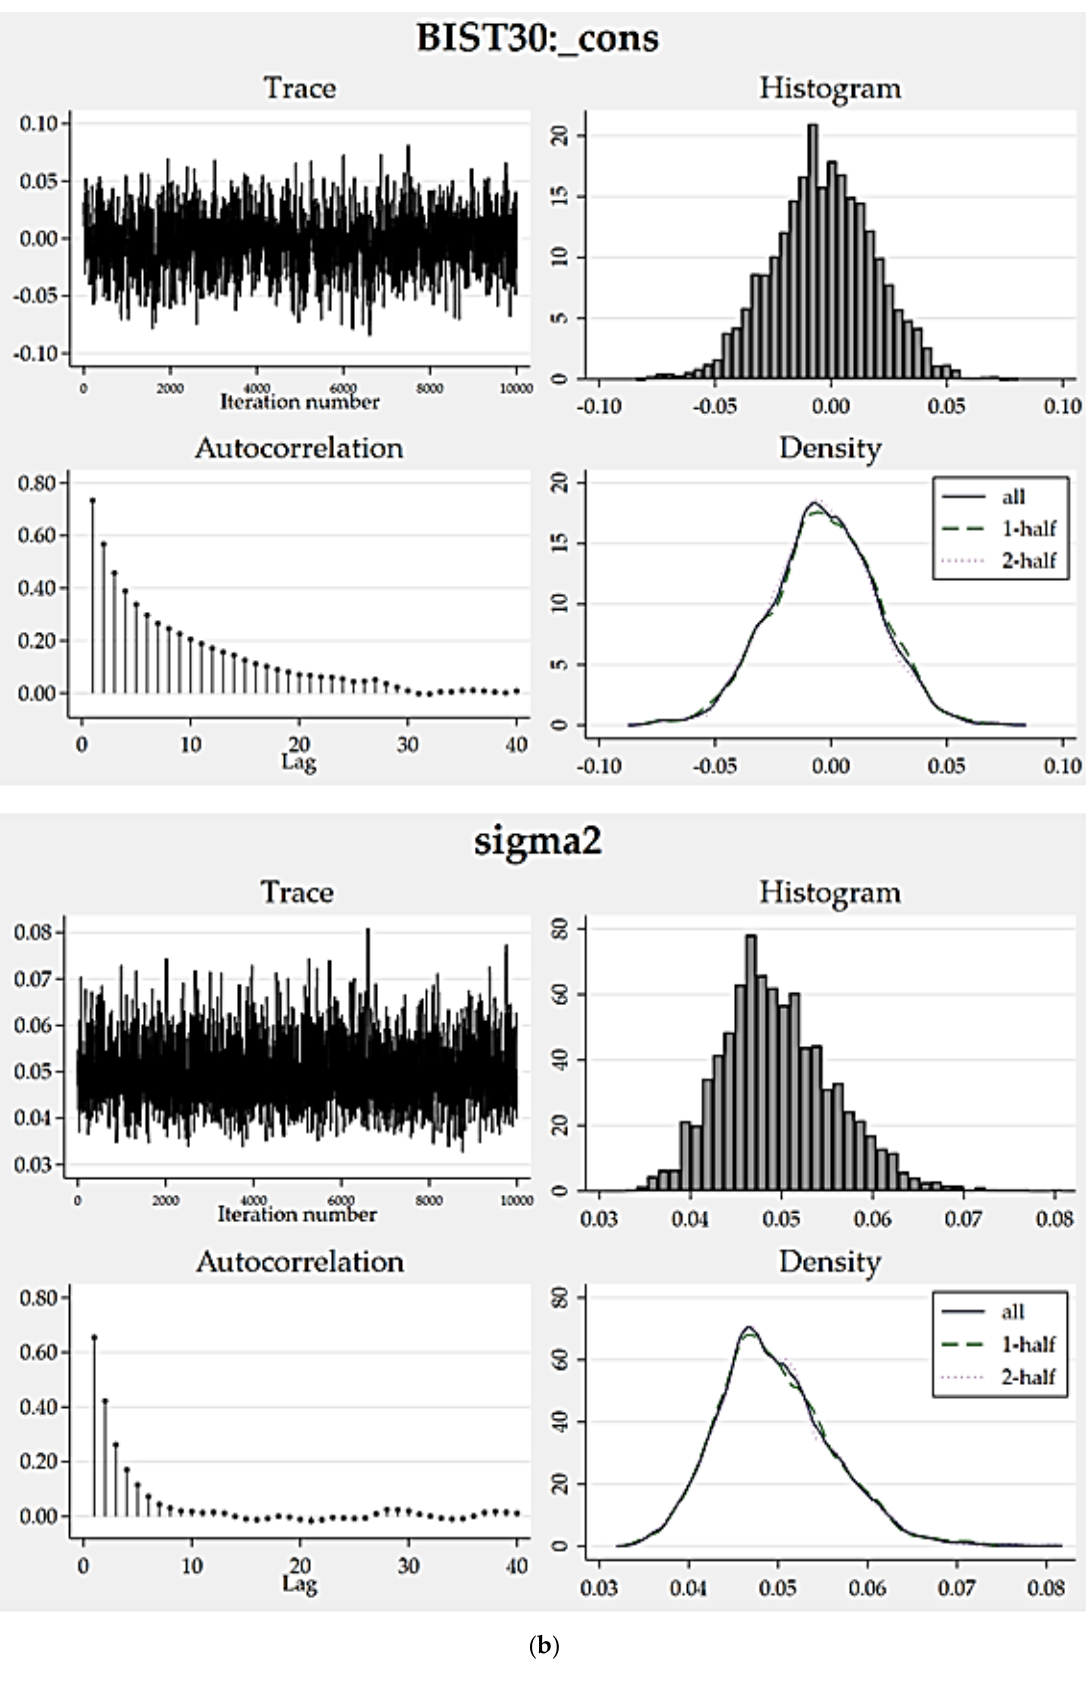
Figure 1. ( a ) BIST 30 convergence graphs for MPREM and CGIOVERM. ( b ) BIST 30 convergence graphs for model constant and variance. Source: STATA output (author’s compilation).